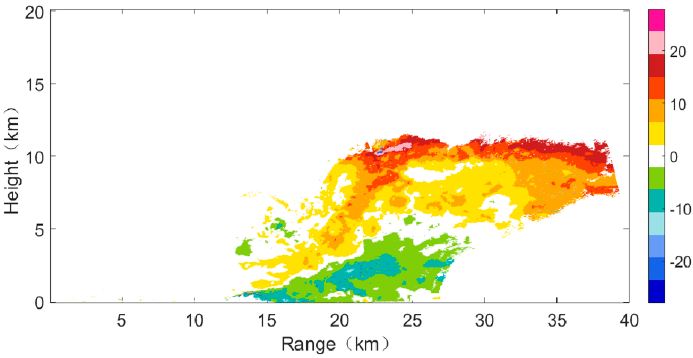
Figure 8. RHI scan of radial wind speed (m/s) at the azimuth of 37° at 20:33 UT on 30 July 2017.